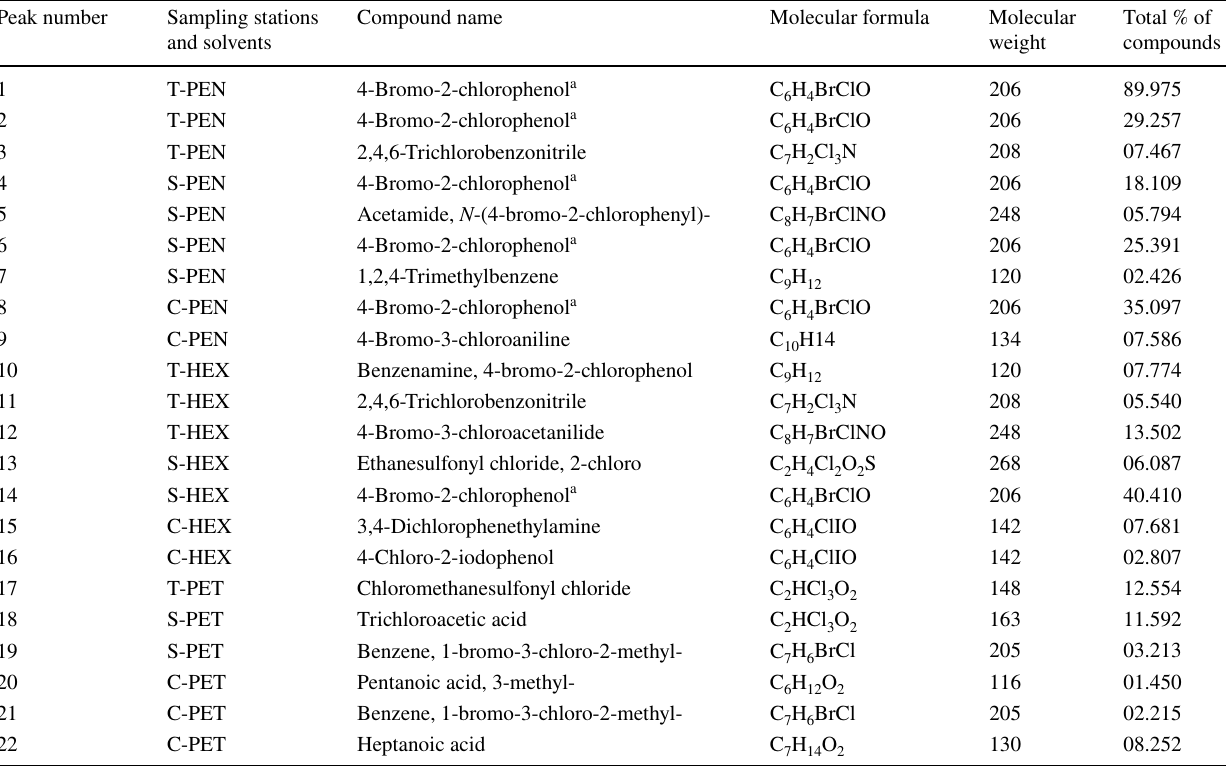
Table 2 GC–MS analysis of water samples extracted using different